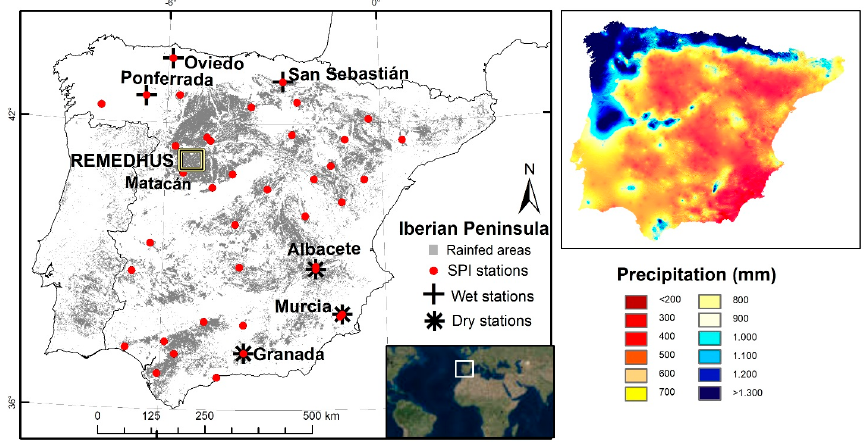
Figure 1. Spanish Meteorological Agency (AEMet) weather stations overlapping the rainfed domain map ( n = 39) in which SPI is available. Map of the average annual precipitation is also shown [43,44], as well as the area of the soil moisture measurement stations network of the University of Salamanca,